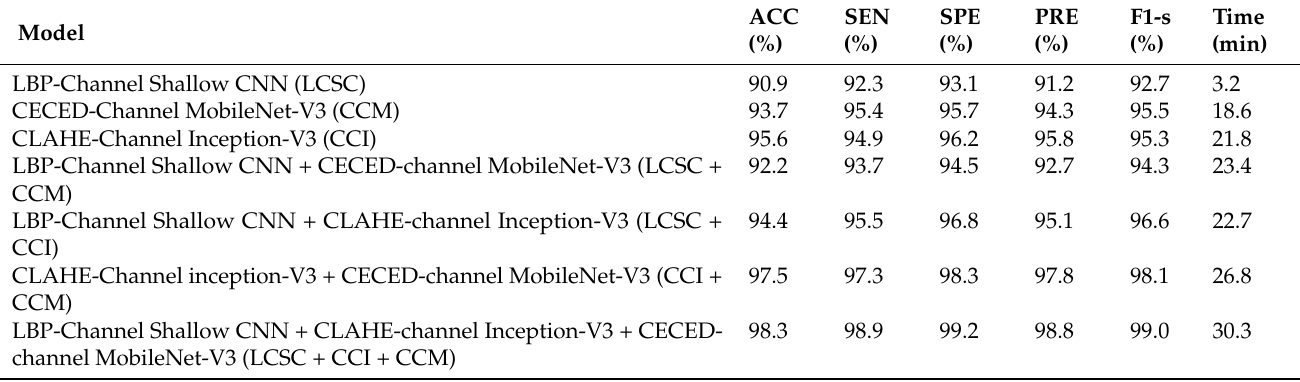
Table 4. Comparison of our proposed model with single channels and dual